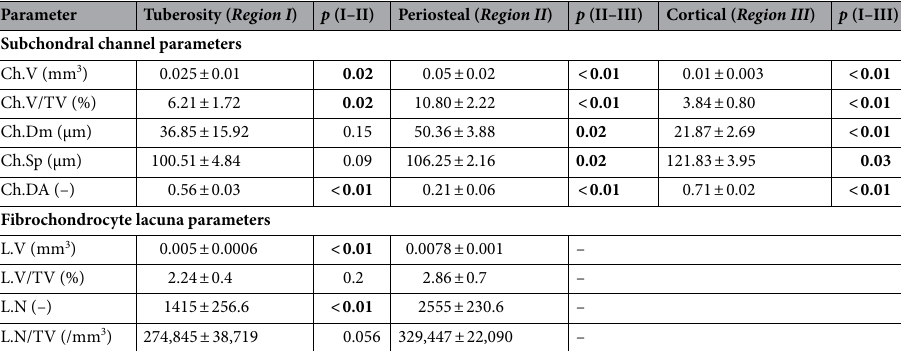
Ch. underlines that channels pointed upwards (dorsally) in the direction of the tendon. The three regions had heat maps significantly different from each other, as indicated by a two-dimensional Kolmogorov–Smirnov test ϕ (p < 0.01, Supplementary Table S1). The channels were further classified, according to their aspect ratio Ch.ρ, into three groups: thick (Ch.ρ ≥ 1), slender (0.1 < Ch.ρ < 1) and extremely slender (Ch.ρ ≤ 0.1) channels. Frequency distributions of Ch. were obtained in the different regions and for the three groups (Fig. 6d). In the tuberosity, all distributions showed a clear peak but different peak positions and widths. Considering extremely slender chan- ϕ nels, located predominantly on the Achilles tendon insertion side of the tuberosity (Fig. 6b), the most frequent